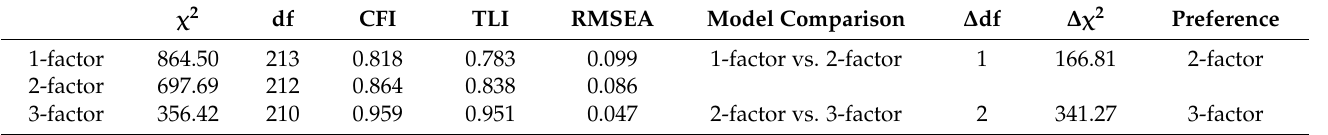
Table 3. Chi-square difference tests among alternative measurement models.